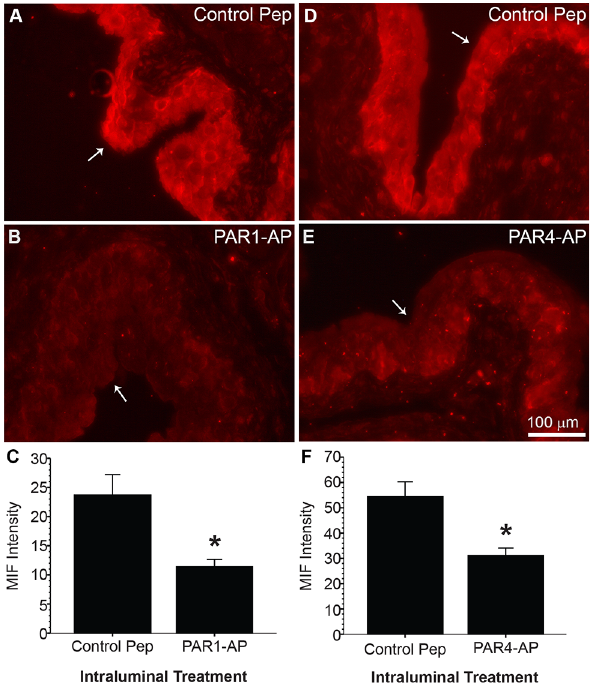
Fig 3. PAR1 or PAR4 activation reduces urothelial MIF in mouse bladder. Female mice under anesthesia, received intravesical instillation of a PAR1 or PAR4 activating peptide (AP) or a respective scrambled peptide (Control Pep: RLLFT-NH2 for PAR1; YAPGKF-NH2 for PAR4) for one hour before harvesting bladders. Panels ( A , B , D , E ) show MIF immunofluorescent labeling in representative bladders. White arrows point to intraluminal surface of the urothelia. MIF immunofluorescent labeling localized to urothelium ( A, D ) and a decrease in urothelial MIF immunofluorescence was observed after PAR1-AP ( B ) or PAR-4-AP ( E ) treatment when compared to control peptide-treated groups ( A , D ). Densitometry showed that average urothelial MIF immunofluorescence (N = 6 per group) significantly decreased after intravesical PAR1- ( C ) or PAR4-AP ( F ) treatment when compared to respective control groups ( * p (cid:1) 0.05).